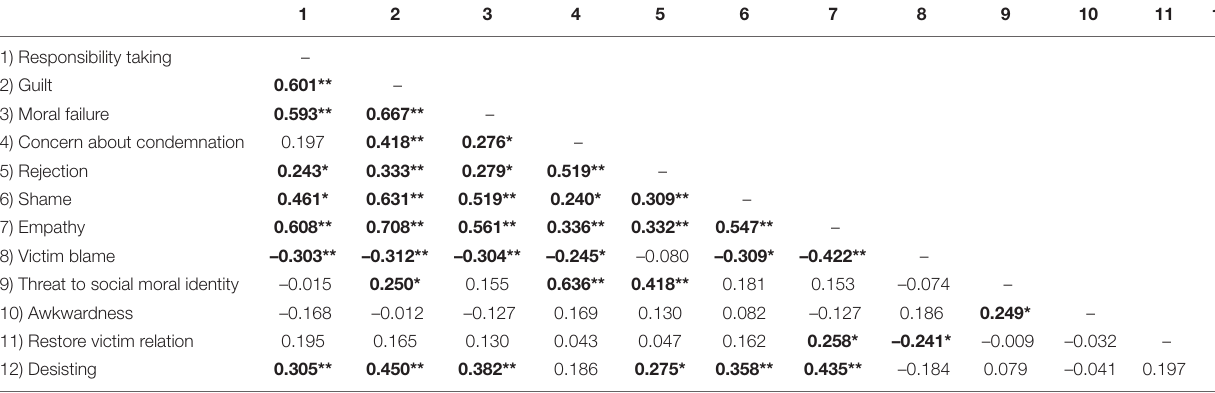
TABLE 4 | Pearson correlations between the dependent variables on the